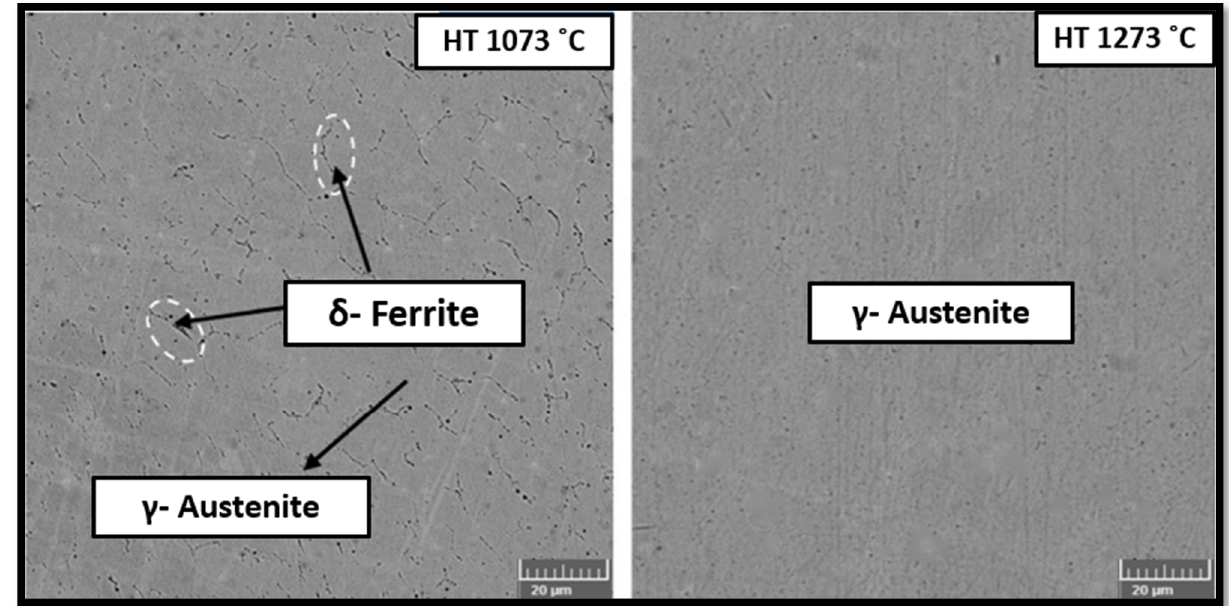
Figure 20. SEM images at different HT temperature.